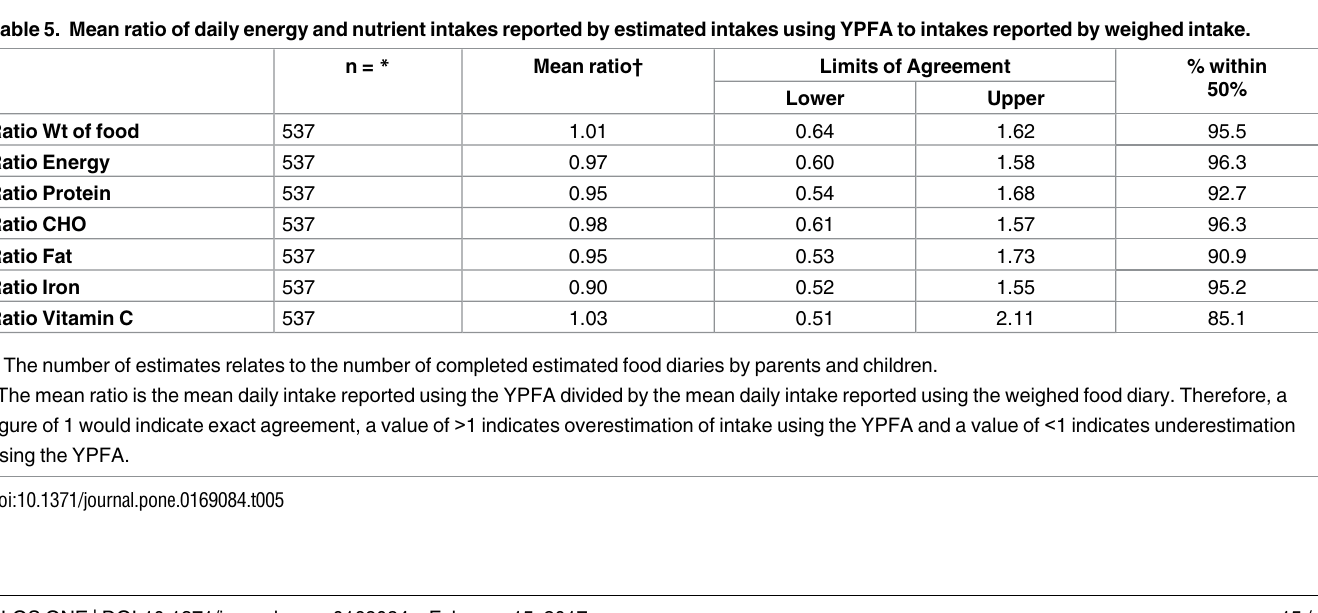
Table 5. Mean ratio of daily energy and nutrient intakes reported by estimated intakes using YPFA to intakes reported by weighed intake. n = * Mean ratio†